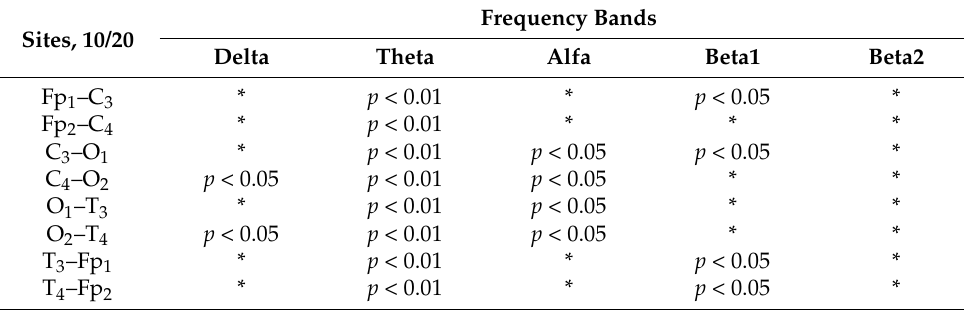
Table 5. Statistical significance of EEG power spectra.